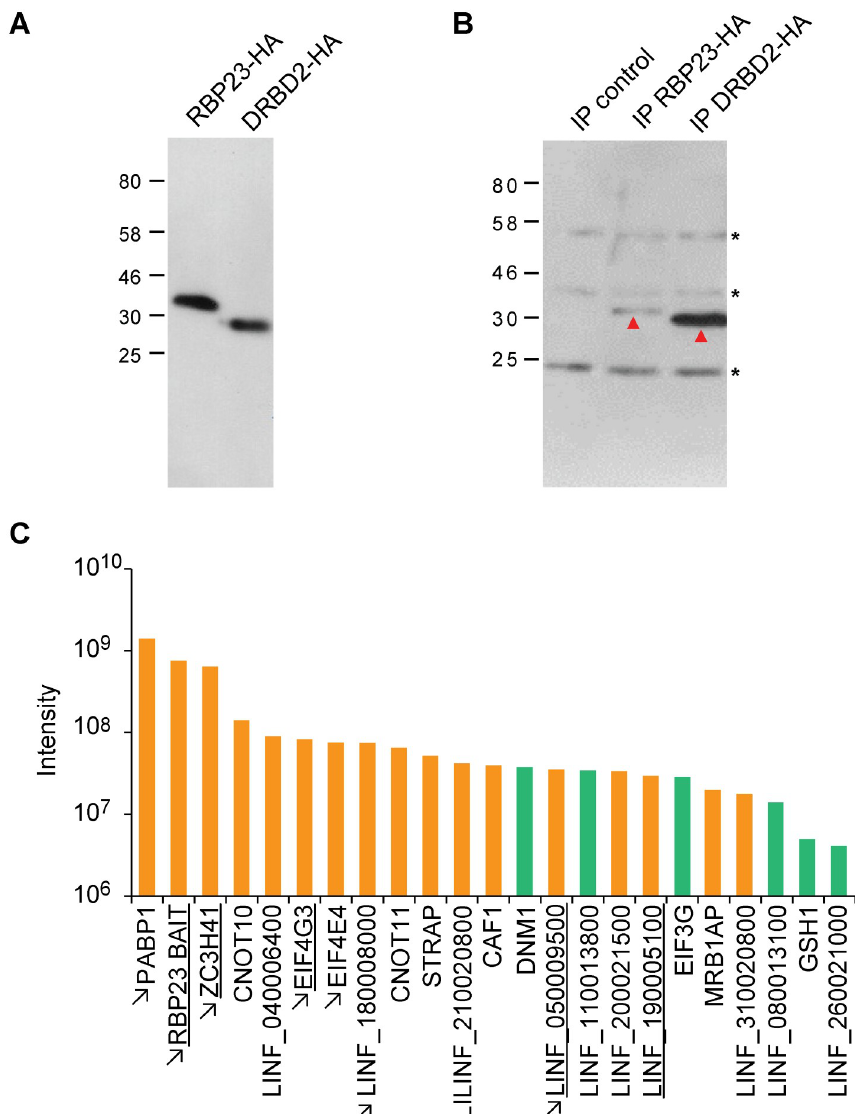
enrichment strength defined as ‘+++’ (orange) and ‘++’ (green), according to Table 2. Proteins co-precipitated with both L . infantum HA-tagged PABP1 [33] and RBP23 are indicated by arrows. Proteins found to co-precipitate also with DRBD2 are